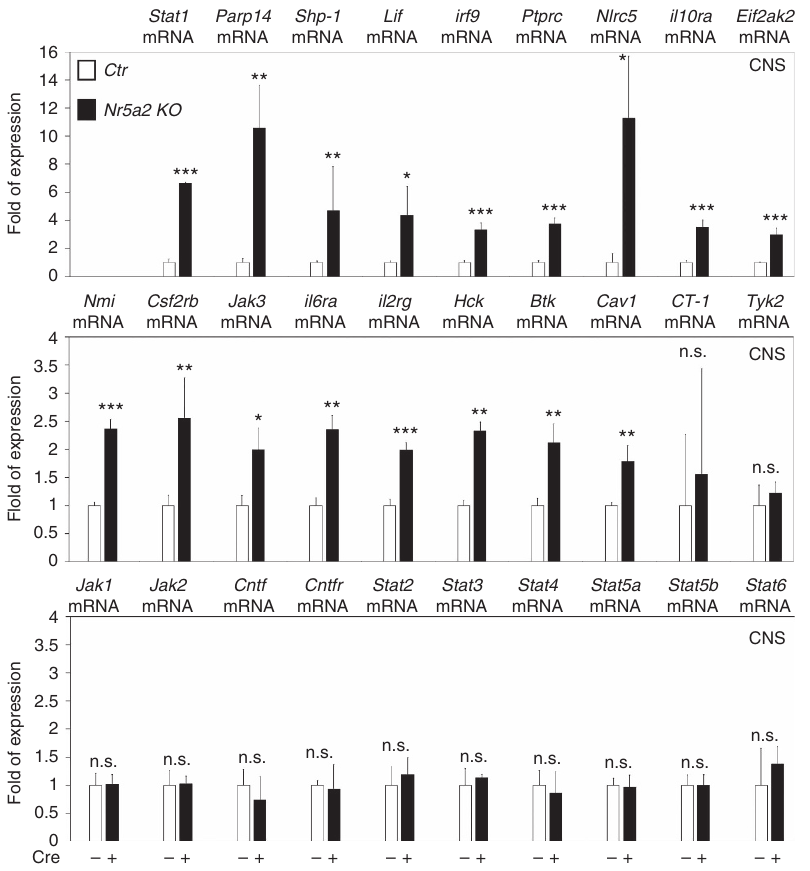
Figure 9 | NR5A2 represses JAK/STAT signalling. RT–qPCR analysis in E12.5 CNS of Ctr and Nr5a2 KO animals for the detection of mRNA levels of a number of genes involved in JAK/STAT pathway, as indicated. All values represent the mean ± s.d. of four animals ( n ¼ 4). NS, not significant. P 4